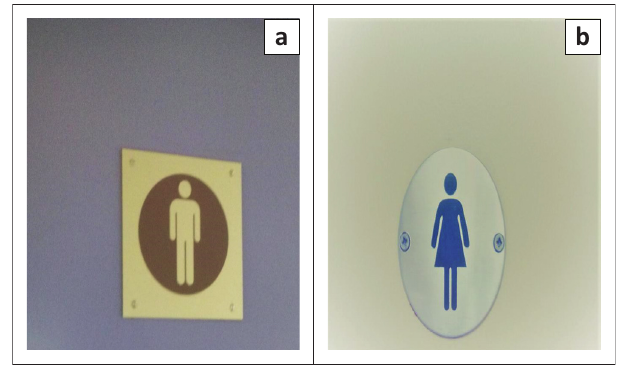
FIGURE 1: (a, b) Toilet sections for the able-bodied.